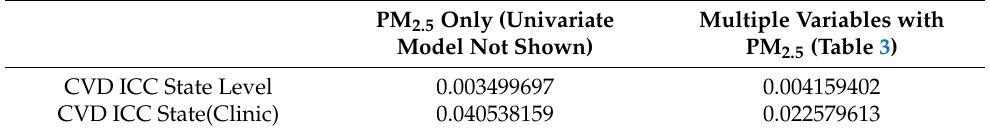
Table 4. Interclass Correlation for